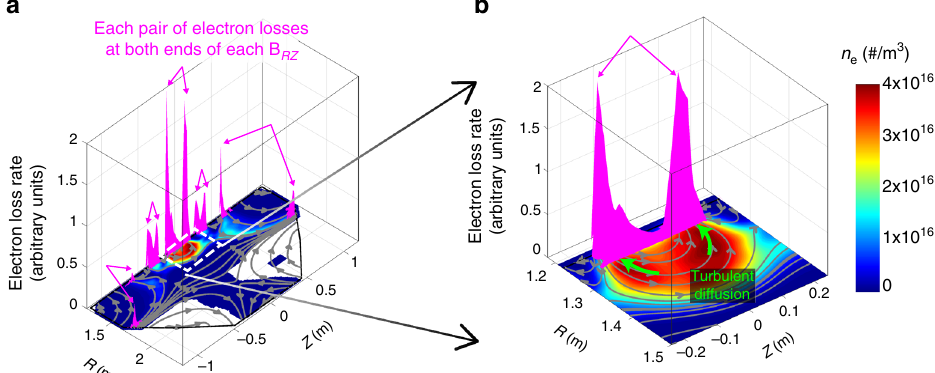
Fig. 8 Dominant plasma losses due to the turbulent diffusion along B RZ . a Color contour plot indicates the linear-scale electron density in the RZ plane. The magnitude of the electron loss to the wall is represented in magenta along the wall trajectory. Each pair of magenta arrows indicates each pair of the electron losses at both ends of each poloidal magnetic fi eld line ( B RZ ). b Enlarged graphs of the electron density and loss at the inboard center. The turbulent diffusion (green) along B RZ by the turbulent ExB mixing causes the pair of electron losses with the same magnitude (see Supplementary Movie 3 for